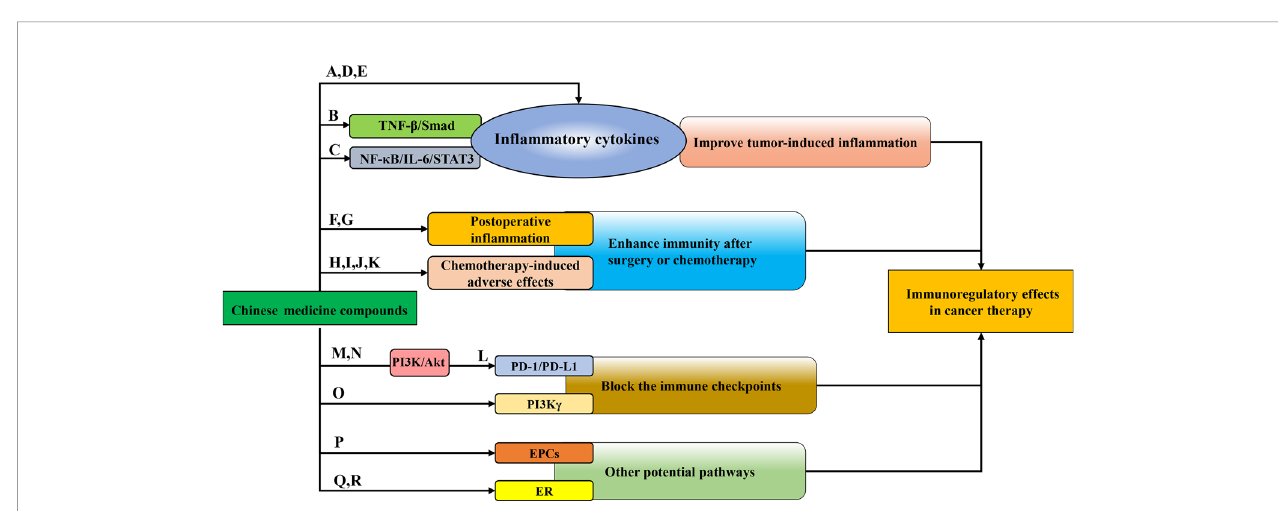
FIGURE 2 | The immunoregulatory patterns of Chinese medicine compounds in cancer therapy. Chinese medicine compounds: (A) Banxia Xiexin decoction; (B) Compound kushen injection; (C) NHE-06; (D) Ruyiping+Platycodon grandi fl orum; (E) Kejinyan decoction; (F) DahuangZhechong Pills; (G) San Huang decoction; (H) PHY906; (I) Ciji-Hua ’ ai-Baosheng; (J) Gegen Qinlian decoction; (K) Yangyin Fuzheng Decoction; (L) Bu Fei Decoction; (M) Huoxue Yiqi Recipe-2; (N) Bu-zhong- yi-qi decoction; (O) Modi fi ed Jian-pi-yang-zheng decoction; (P) Danggui Buxue decoction; (Q) XH formula; (R) Shugan Liangxue